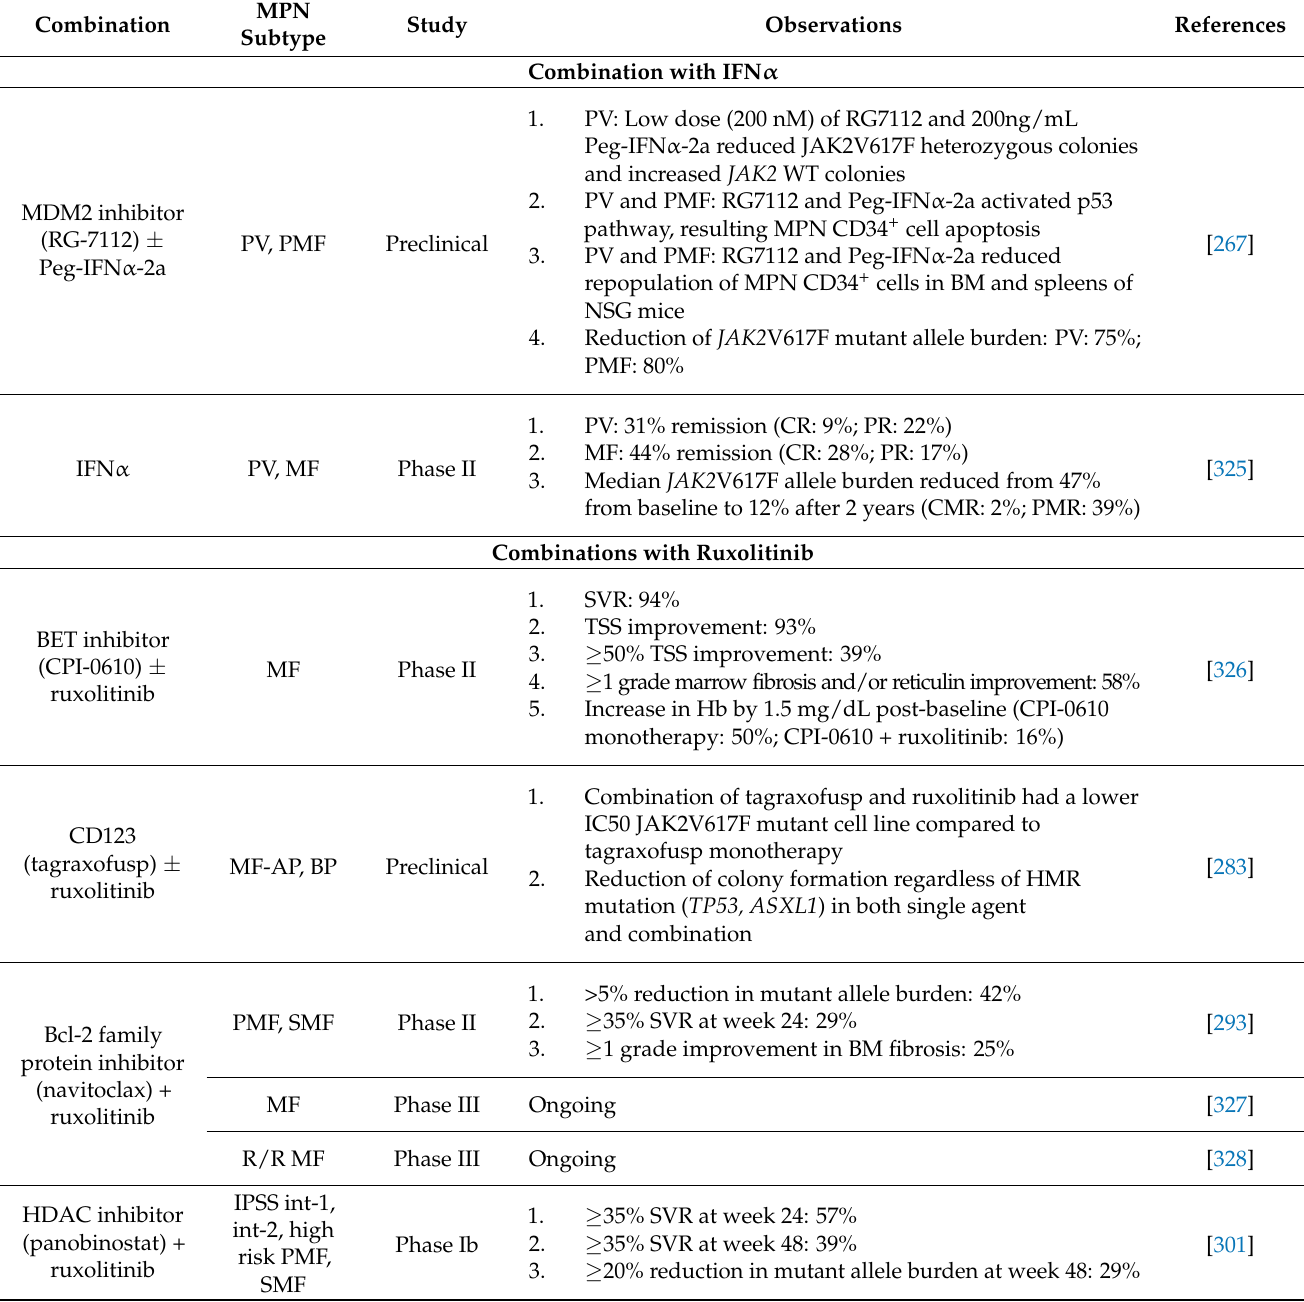
Novel therapies in combination with standard treatment (interferon-alpha/ruxolitinb) in targeting Ph-negative